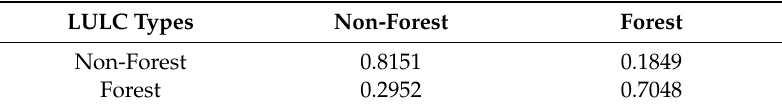
Table 6. Markov transition probability matrix of simulated LULC map 2018.